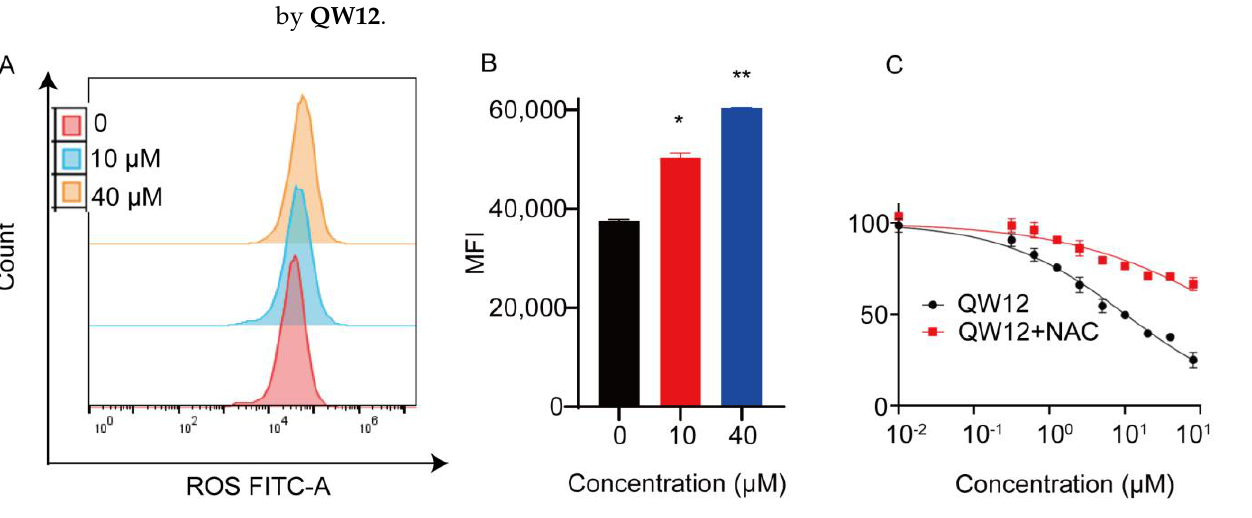
Figure 5. QW12 induces intracellular ROS generation. ( A ) Concentration-dependent induction of the ROS content in HeLa cells by QW12 for 6 h. ( B ) Quantitative statistics of the results in A using the GraphPad software. ( C ) HeLa cells were pretreated with NAC (5 mM, 1 h) prior to incubation with QW12 for 48 h. The results of CCK-8 showed that NAC inhibited the effect of QW12-induced cytotoxicity. ( D ) HeLa cells were pretreated with NAC (5 mM, 1 h) prior to incubation with QW12 for 6 h. The results of flow cytometry showed that NAC inhibited the effect of QW12-induced ROS